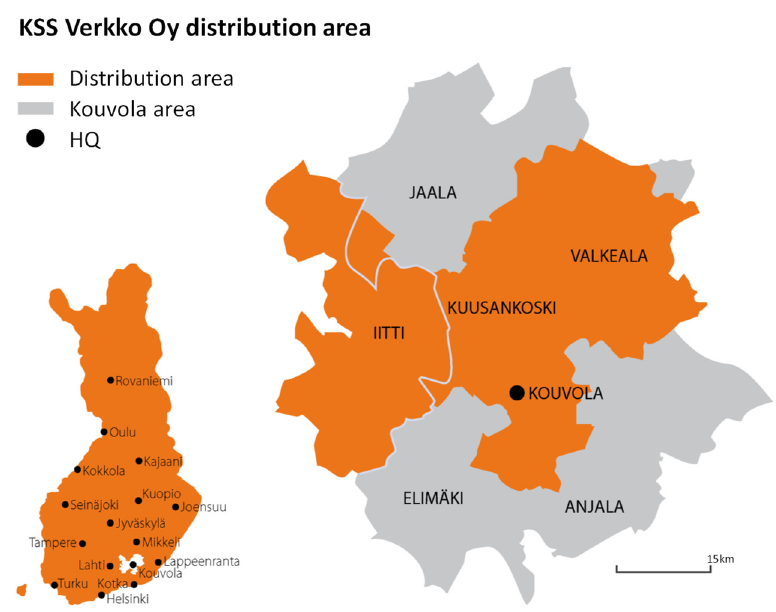
Figure 2. Geographical area of KSS Verkko’s distribution area.